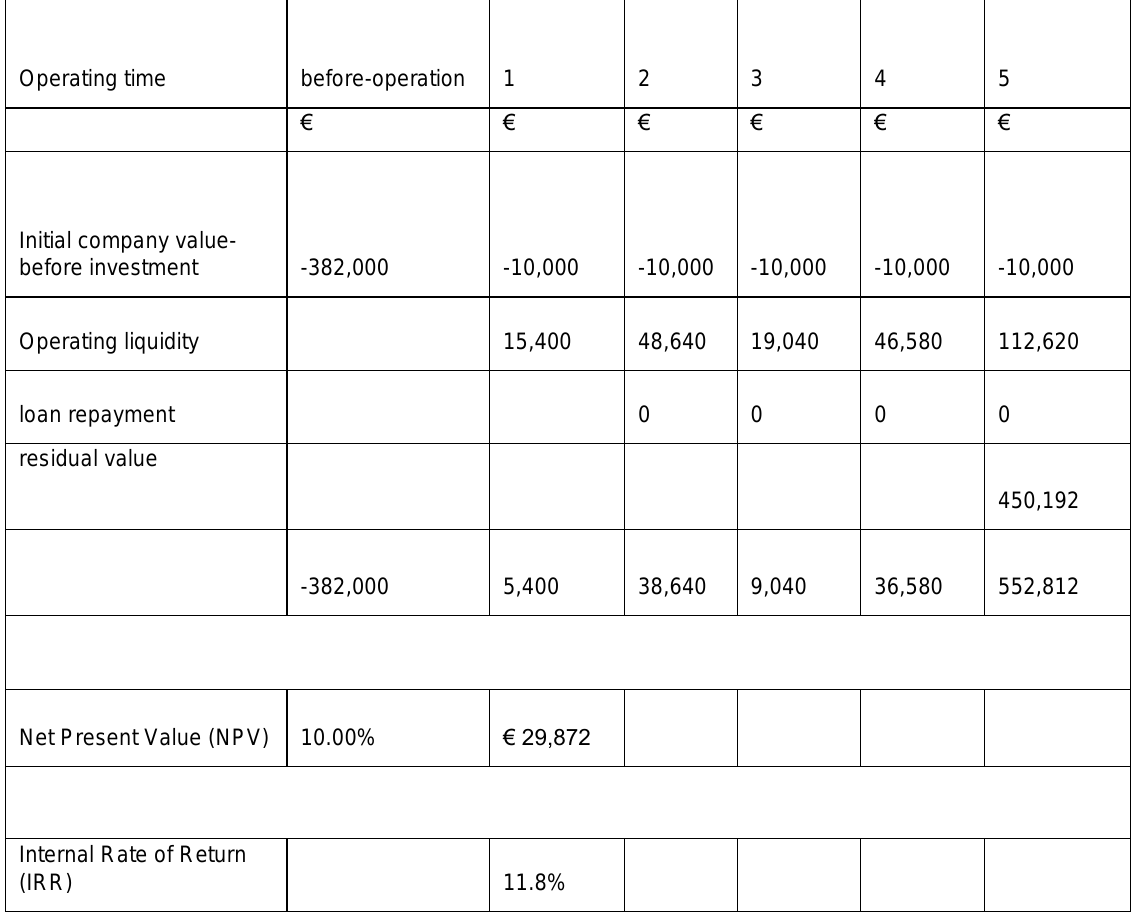
Table 4. Discounted Cash Flow